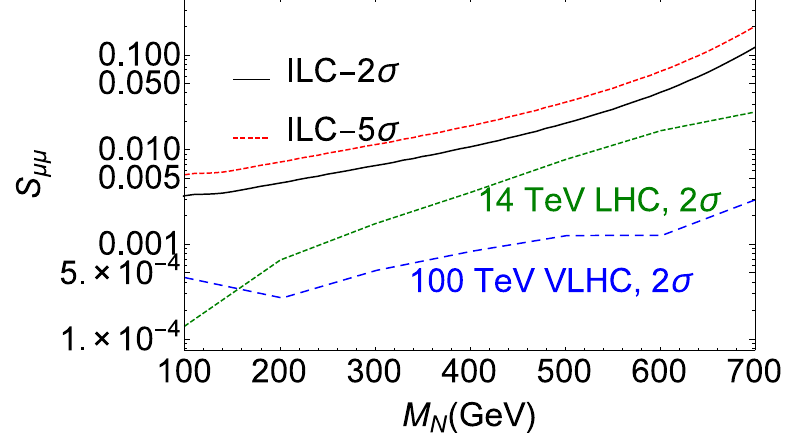
Figure 12 . Sensitivity on S (cid:22)(cid:22) at the ILC, compared to the updated result at 14 TeV LHC and the new estimation at 100 TeV VLHC